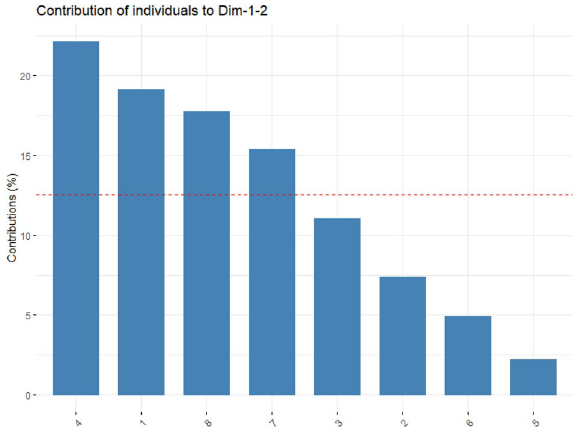
Figure 8. Graphical illustration of individual contribution of the treatments to PCs. (1) Control—NI; (2) Control—HD; (3) Claroideoglomus etunicatum —NI; (4) Claroideoglomus etunicatum —HD; (5) Rhizophagus clarus —NI; (6) Rhizophagus clarus —HD; (7) Rhizophagus intraradices —NI; (8) Rhizophagus intraradices —HD. HD Hydric deficit and NI normaly